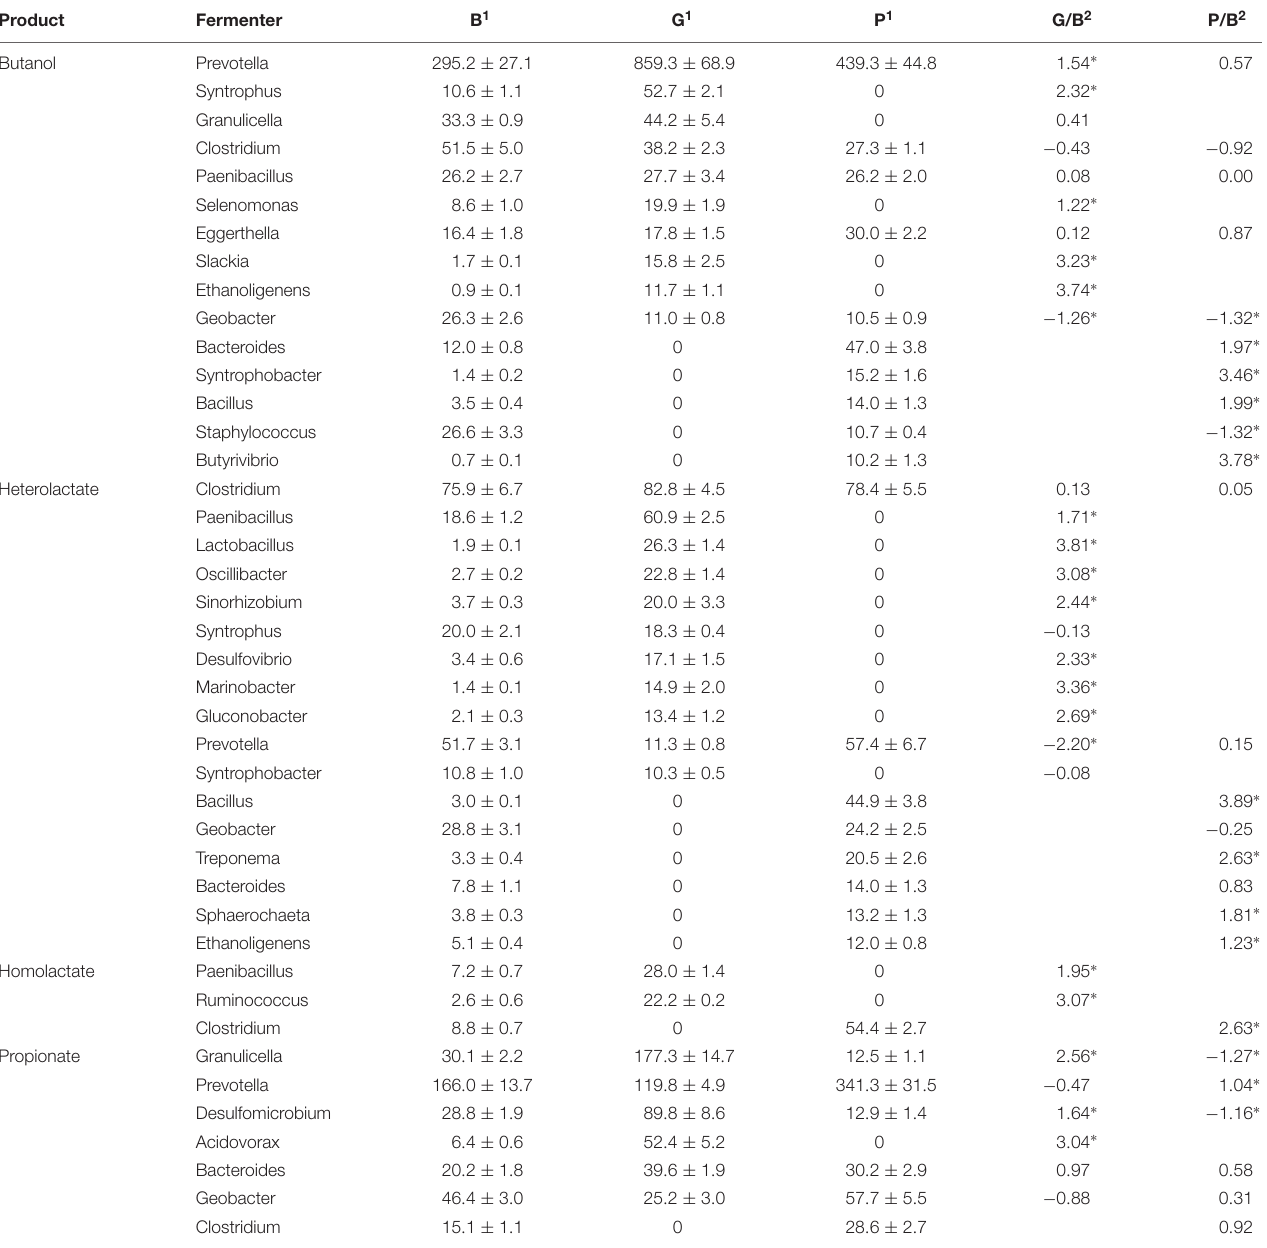
TABLE 4 | Comparisons of the relative abundance of specific fermenters between groups.